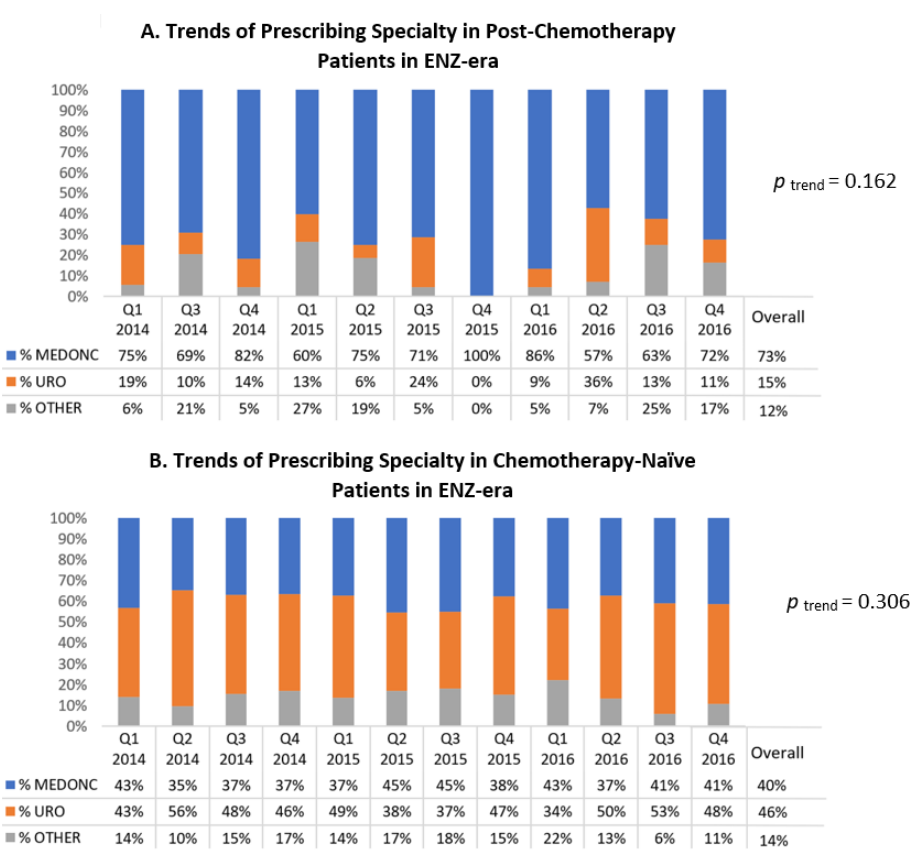
Figure 3. Trends of prescribing specialty of novel hormonal agent (NHA) initiators stratified by chemotherapy status in ENZ-era. ( A ) Trends of prescribing specialty among post-chemotherapy patients. ( B ) Trends of prescribing specialty among chemotherapy-naïve patients.